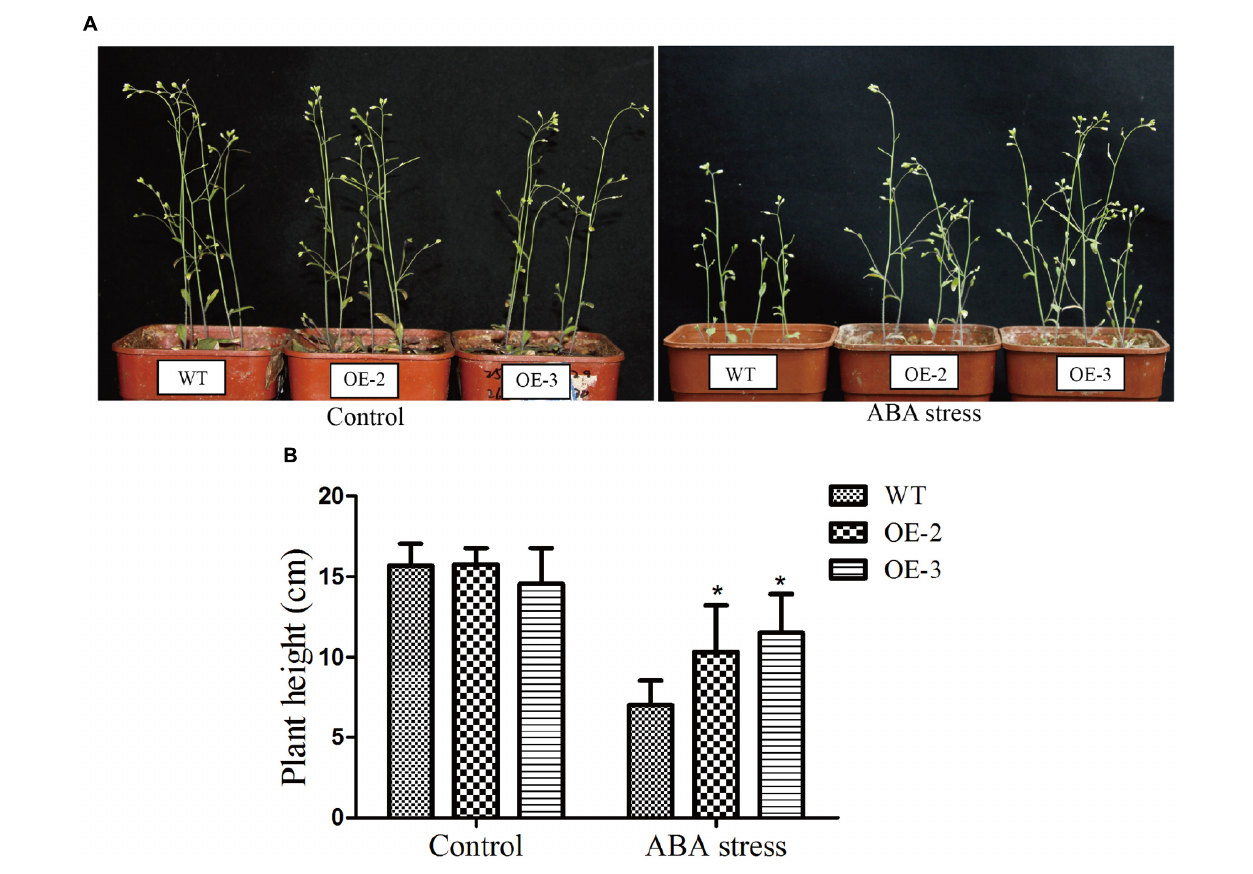
FIGURE 9 | Phenotype assay of the GmRAV-03 overexpression transgenic Arabidopsis grown in soil under ABA stress. (A) Phenotype of the GmRAV-03 overexpression transgenic Arabidopsis and WT grown in soil under ABA stress . (B) Height of the GmRAV-03 overexpression transgenic Arabidopsis and WT under ABA stress. The data are shown as mean ± SD ( n = 45). Independent t -tests demonstrated that there was significant difference ( ∗ P <